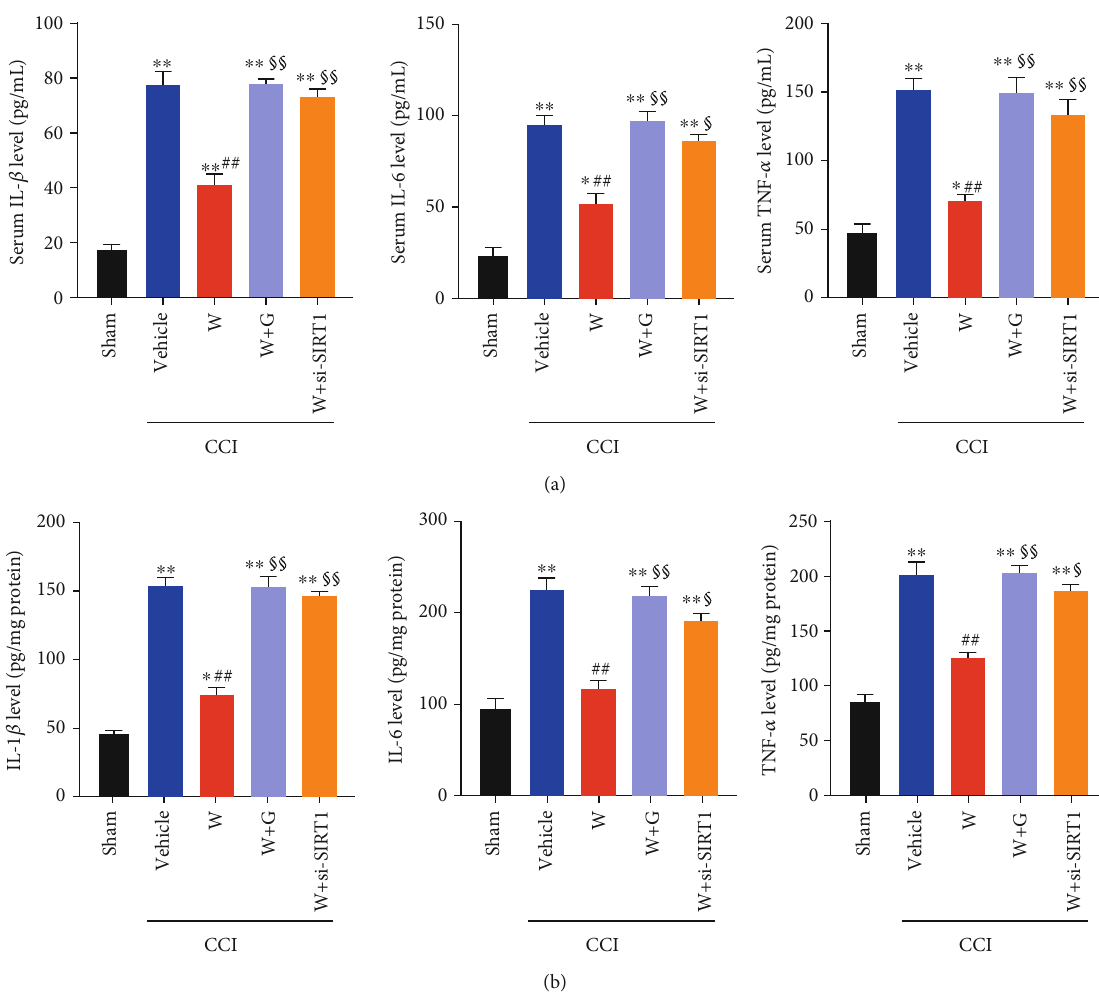
Figure 3: Repeated WY-14643 administration reduced in fl ammation in CCI rats by activating PPAR α . (a) WY-14643 reduced IL-1 β , IL-6, and TNF- α levels in serum of CCI rats, whereas GW6471 and si-SIRT1 reversed the anti-in fl ammatory e ff ect. (b) WY-14643 reduced IL-1 β , IL-6, and TNF- α levels in the spinal cord of CCI rats, whereas GW6471 and si-SIRT1 reversed the anti-in fl ammatory e ff